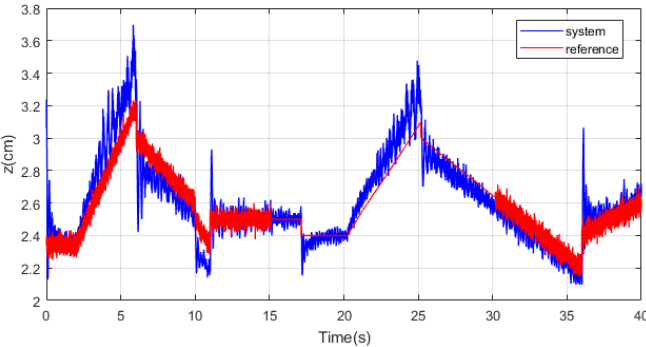
Figure 11. Random reference and system response with the lead–lag controller.